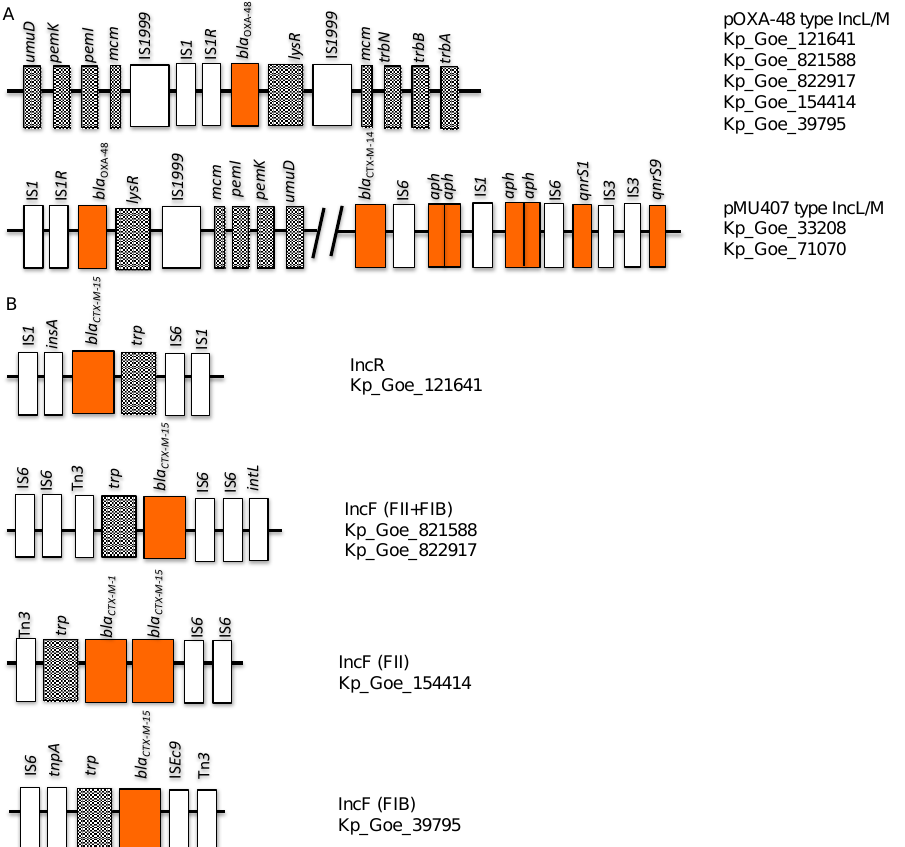
Figure 4. Summary of the genetic synteny of bla OXA-48 , bla CTX-M-14 , and bla CTX-M-15 genes on the plasmids of Klebsiella pneumoniae isolates. ( A ) the locations of bla OXA-48 , bla CTX-M-14 , and other antimicrobial resistance genes on the pMU407 and pOXA-48 type IncL/M plasmids ( B ) the locations of bla CTX-M-15 genes on the IncR and IncF type plasmids.